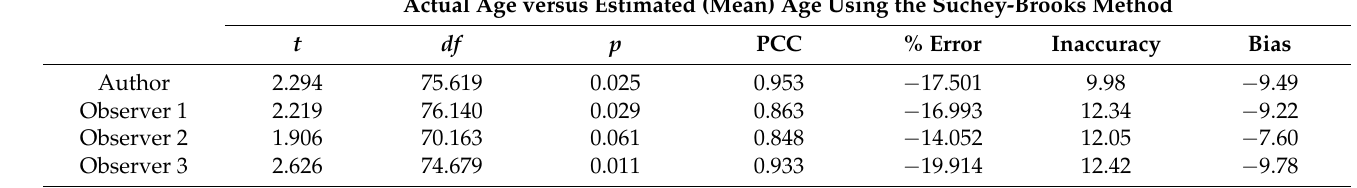
Table 9. Actual age versus estimated (mean) age by method, observer subset (females, n = 50). Actual Age versus Estimated (Mean) Age Using the Suchey-Brooks